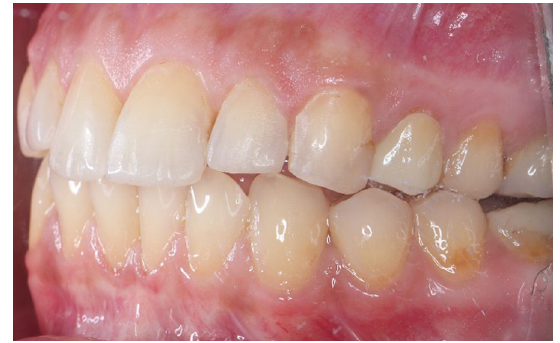
Fig. 3 Final restoration after cementation